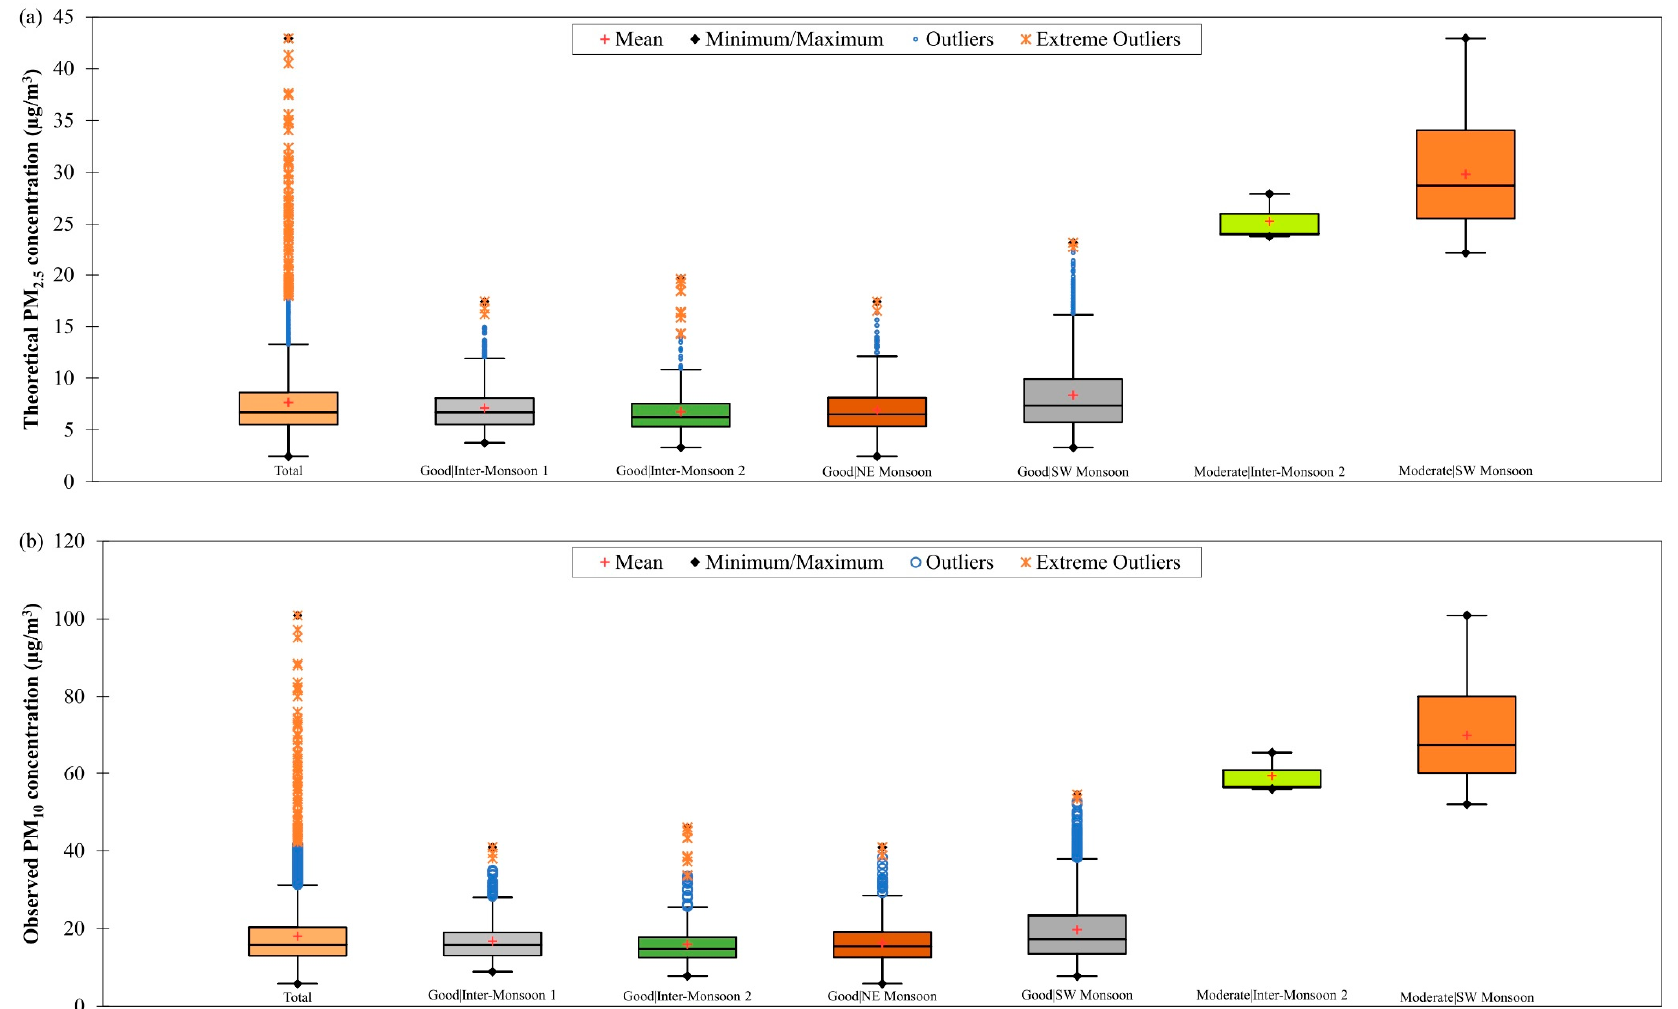
Figure 4. Box plots of ( a ) theoretical daily PM 2.5 concentration and ( b ) observed daily PM 10 concentration in Brunei Darussalam from January 2009 to December 2019 during good and moderate air quality conditions in different monsoon seasons.